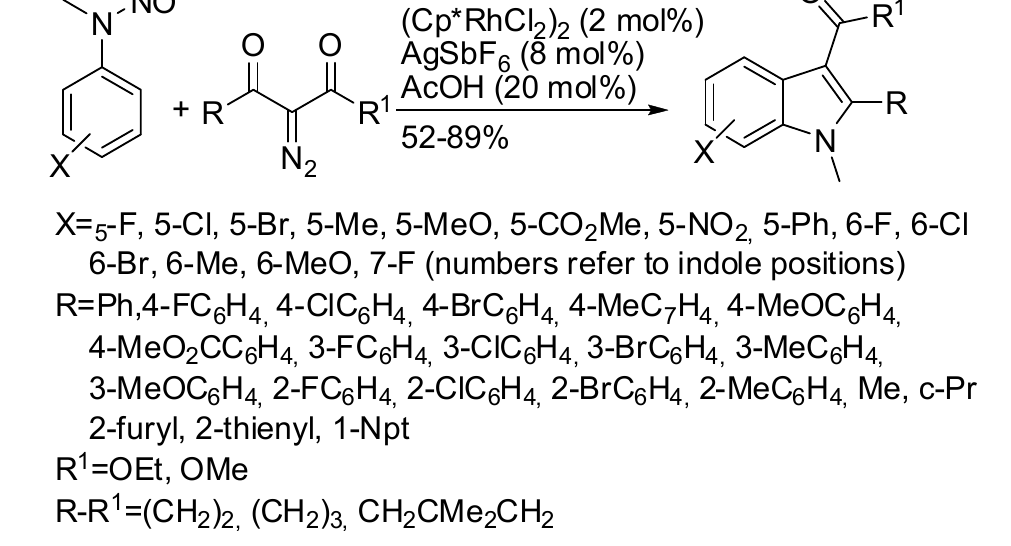
2-acylindoles (Scheme 60) [109], while vinyl esters